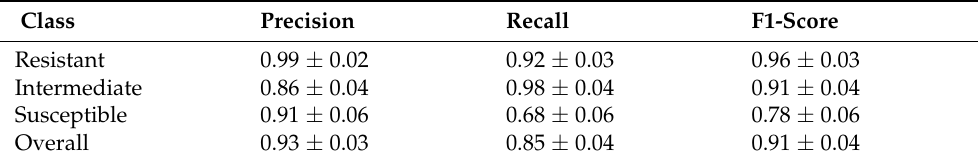
Table 4. Performance (Mean ± SD) during testing using DeepARRNet model trained with the original pea root and augmented data with random oversampling